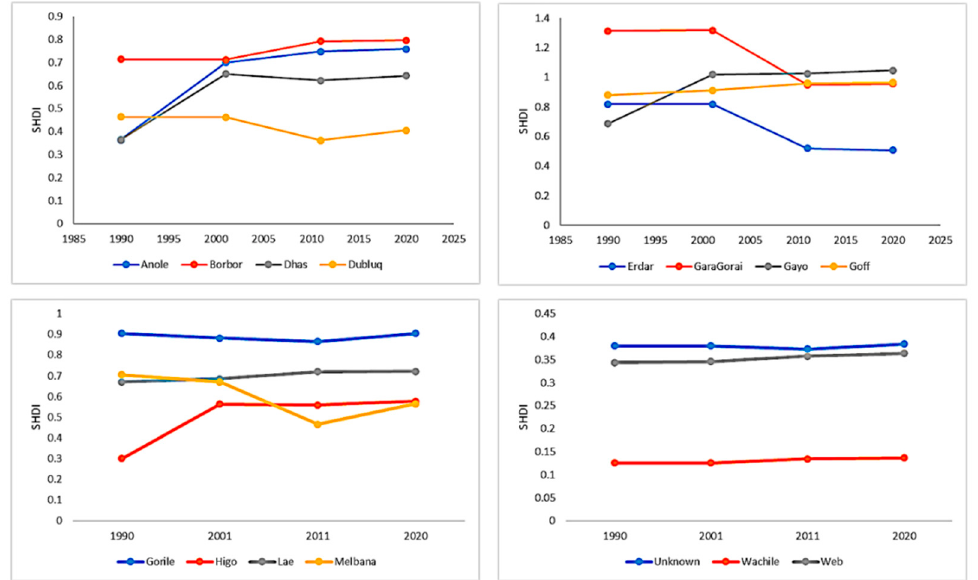
Figure 9. Mean SHDI within a 15 km buffer zone of the tula wells clusters in the Northern Kenya/Southern Ethiopia study region. The y-axis indicates the SHDI values while the x -axis indicates the year. The figures have been separated into four frames for ease of visibility.